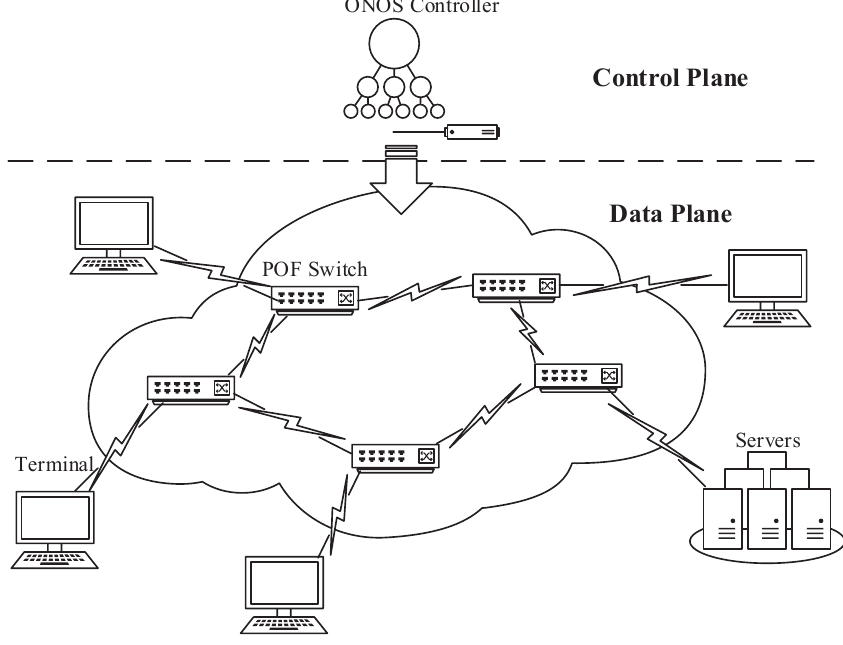
Figure 1. The network system model where our approach